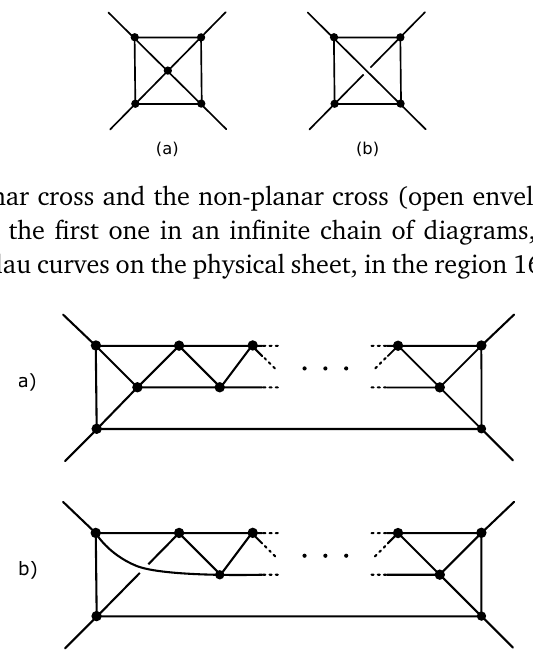
Figure 4: The planar, a), and non-planar, b), triangle chain graphs. Remarkably, each of the graphs involves four-particle scattering both in the s - and in the t - channel. As the number of triangles grows, the corresponding Landau curves quickly accumulate around the locus (1) on the physical sheet. Notice that adding a single triangle to each chain increases the number of vertices V by 2. Closely related diagrams appeared before in [ 2,4,13 ] .